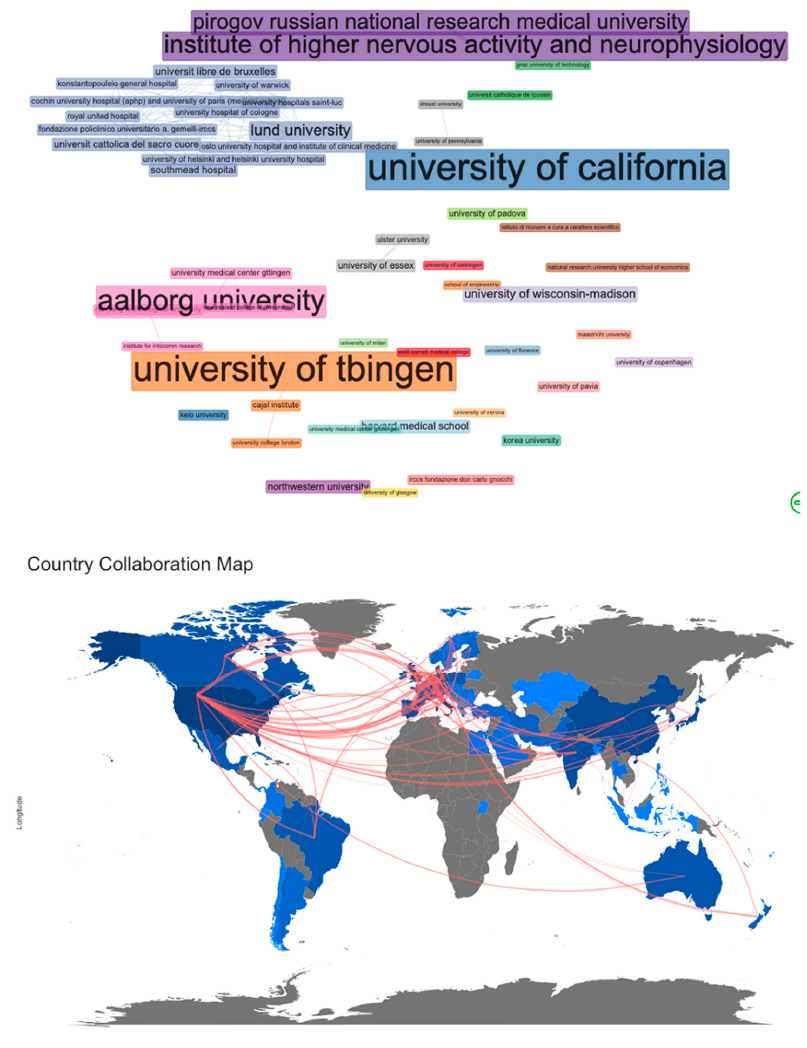
Figure 4. Significant international collaborations among institutions and countries on the use of EEG in neurorehabilitation.